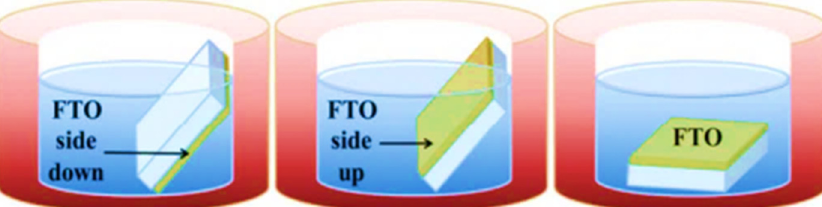
Figure 16. Schematic illustration of the 3-set positions of the FTO-coated side substrate. Reprinted from ref. [161].